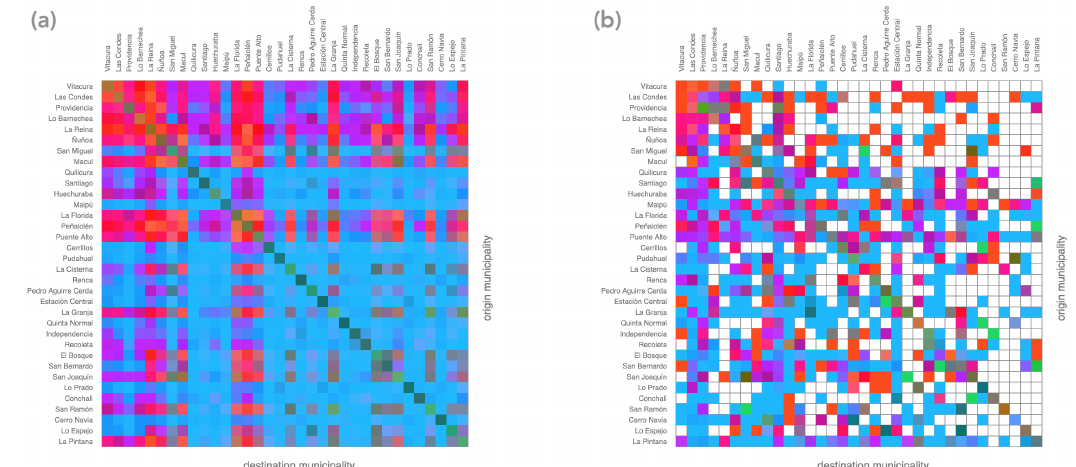
Figure 6. XDR ( a ) and survey ( b ) flows at morning peak 1 at municipal aggregation level. Even at a time period where they show a similar total flow magnitude, the sampling density is